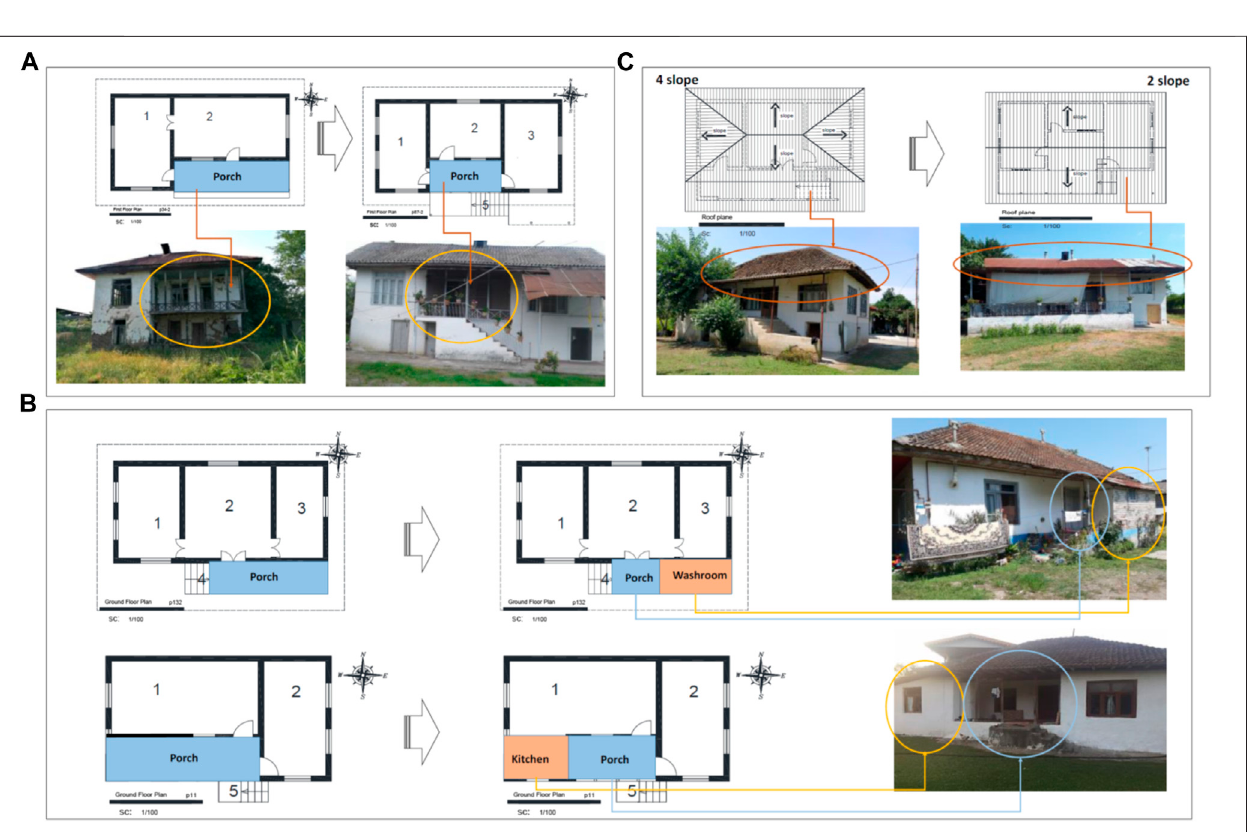
Frontiers in Built Environment |